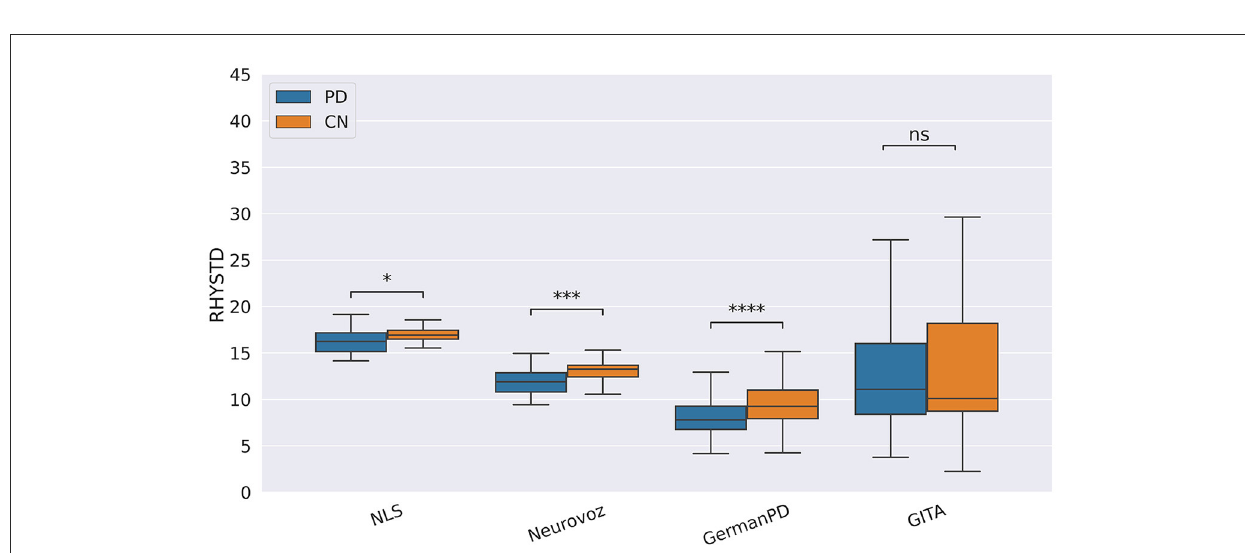
FIGURE8 Boxplots representing the rhythm standard deviation (RHYSTD) on NLS, Neurovoz, GermanPD, and GITA from the SS task. Horizontal lines represent the medians, the top ends represent the upper quartiles, and the bottom ends represent the lower quartiles. Statistically significant differences between groups after Benjamini–Hochberg correction for RHYSTD are reported in Table 6 and highlighted below using asterisks. RHYSTD, rhythm standard deviation; CN, control group; PD, Parkinson’s disease; SS, spontaneous speech; ns, not